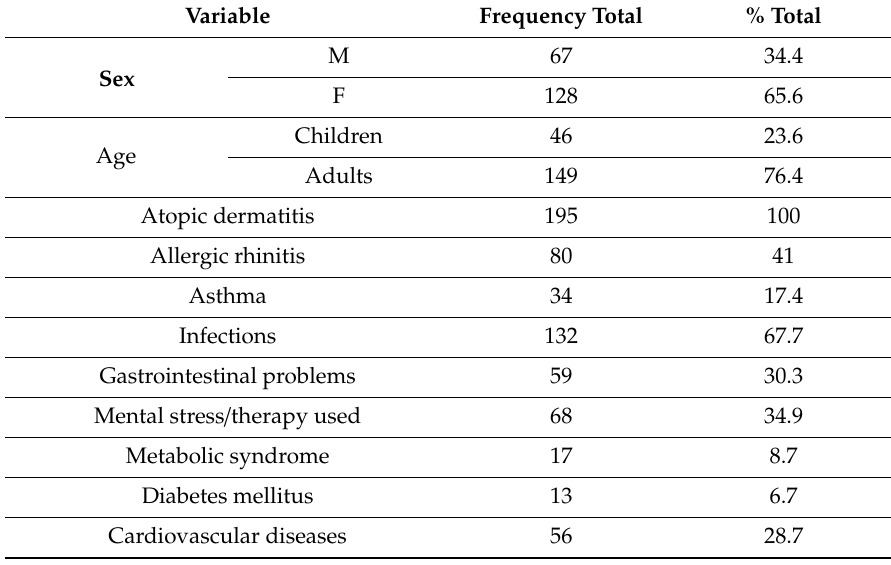
Table 1. The incidence and descriptive data of patients with atopic dermatitis and comorbidities.